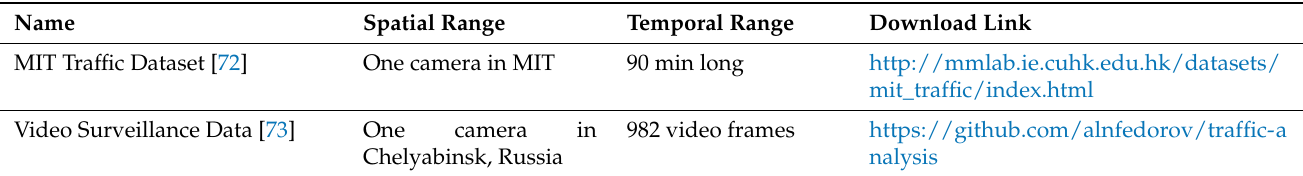
Table 8. The list of open video